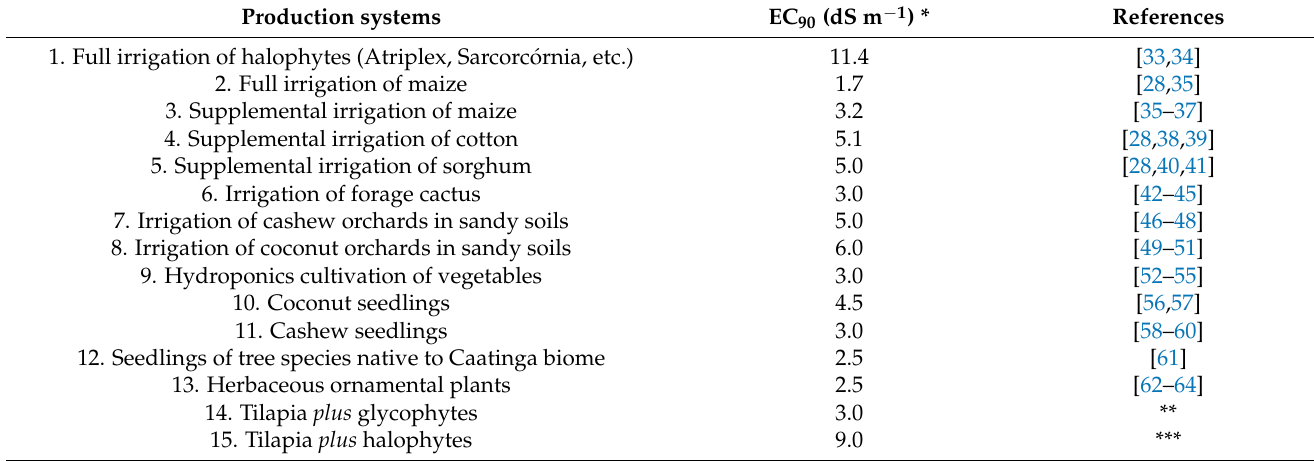
Table 2. Water salinity threshold for 15 production systems, assuming a maximum production loss of up to 10% (EC 90